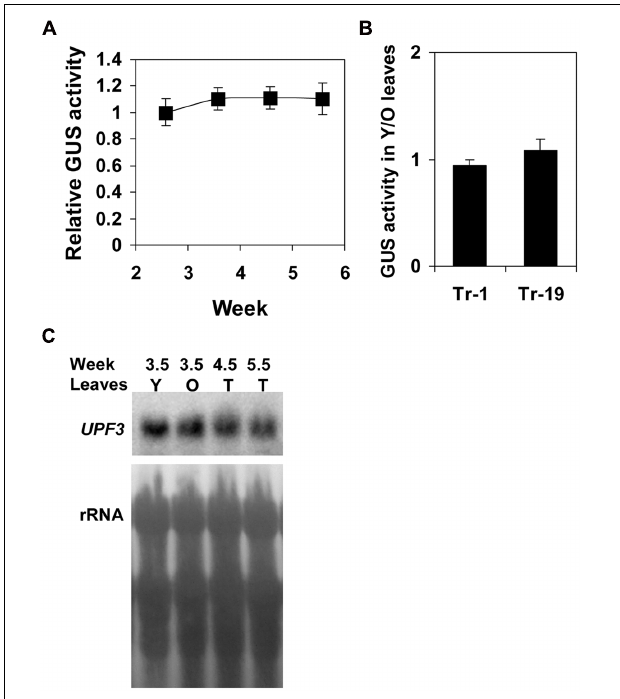
FIGURE 3 | UPF3 expression is equal in leaves at different growth stages. (A) GUS activity in rosette leaves of homozygous transformed plants expressing the U3::GUS construct. Seven biological replicates, each including the leaves of four plants, were analyzed at each age. The plants were germinated at different times and, subsequently, all plants were harvested at the same time to minimize environmental variation. The graph shows the mean of GUS activity of plants at different ages, relative to the activity of 2.5-week-old plants. Error bars represent the standard error (SE). (B) GUS activity in younger relative to older leaves of two different homozygous transformed plants (named Tr-1 and Tr-19) expressing the U3::GUS construct. Seven biological replicates were analyzed for each plant. Each replicate was composed of five 25-day-old plants grown in the greenhouse. The older leaves were true leaves numbers 1–4, and the younger leaves were true leaves numbers 5–7. All the younger and older leaves of each group of five plants were pooled and analyzed, and the ratio of GUS activity (GUS units per mg protein) of the younger relative to the older leaves (Y/O) was determined. Each column shows the mean of the Y/O values of the seven biological replicates analyzed for each plant type. Error bars represent the SE. (C) Northern blot hybridization with the UPF3 gene probe of wild type (WT) plants at the indicated ages. For 3.5-week- (25-day-) old plants, the younger (Y) and older (O) rosette leaves were harvested separately while, for the other ages, the total (T) rosette leaves were harvested together. Plant growth and harvest, as well as the separation to different samples, were carried out as described in (A,B)